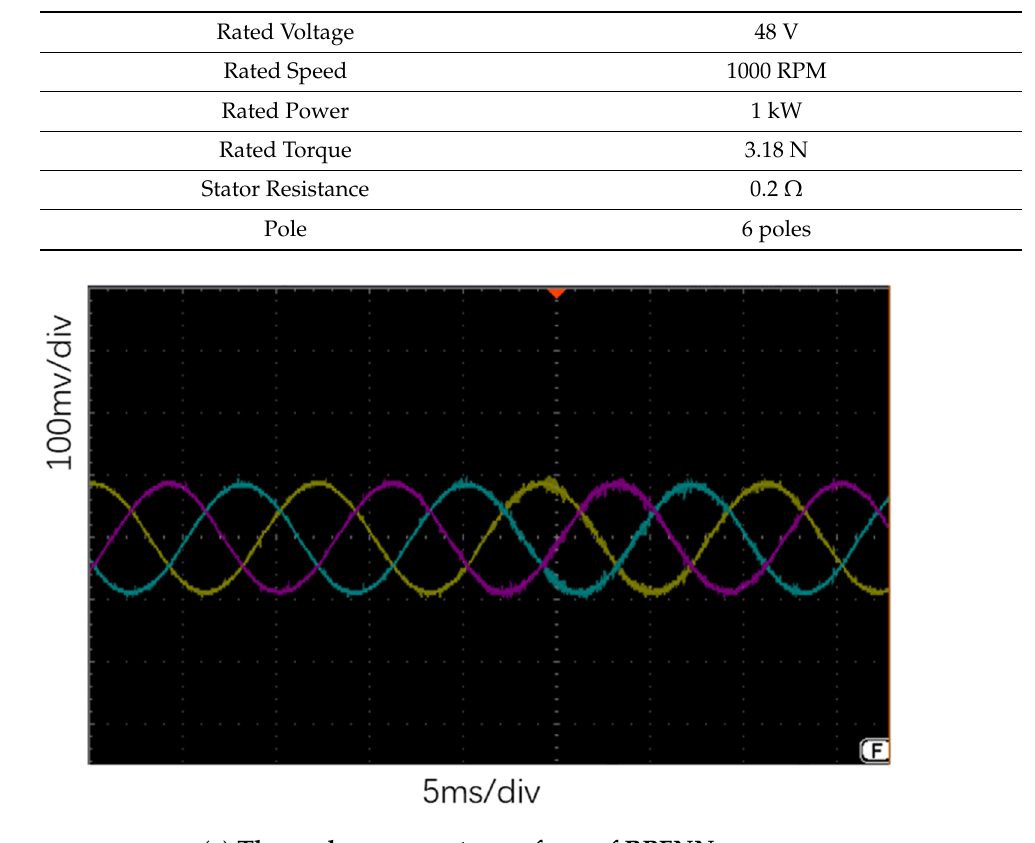
Table 2. Specific parameter of ac servo motor.